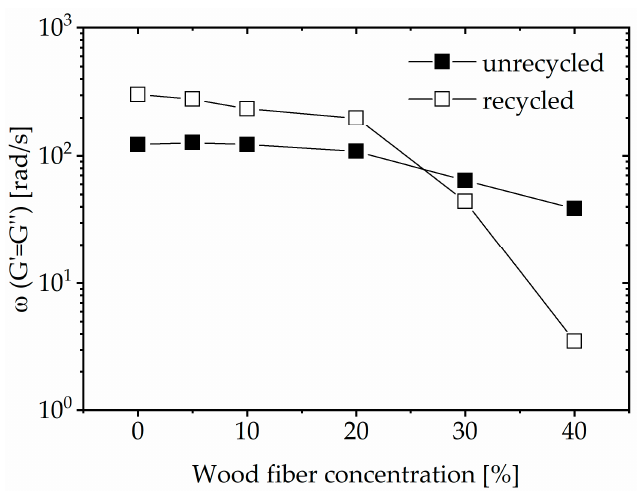
Figure 10. Crossover point at 190 °C for unrecycled (WF ‐ PP) and recycled (WF ‐ R ‐ PP) materials.